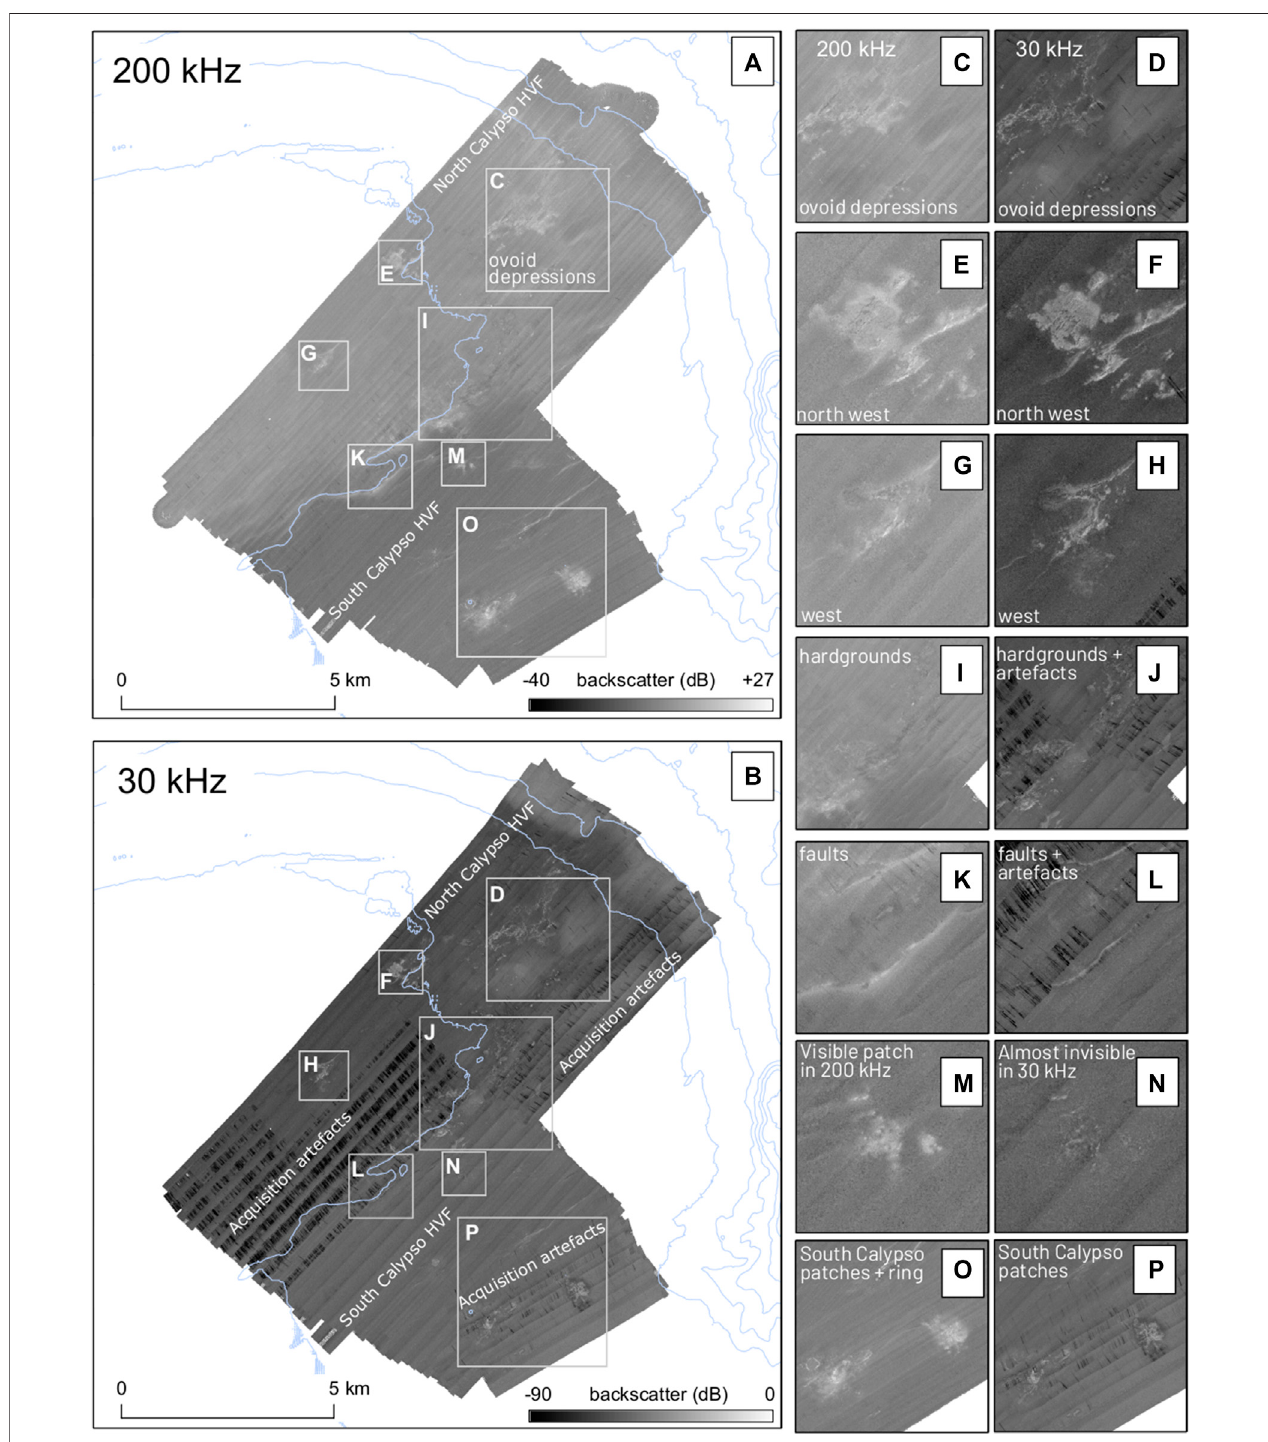
FIGURE3| OriginalCalypsoHVFEM2040(200 kHz)backscattermosaic (A) ,andCalypsoHVFEM302(30 kHz)backscattermosaic (B) , (C) , (D) , (E) , (F) , (G) , (H) , (I) , (J) , (K) , (L) , (M) , (N) , (O) , (P) insets show detailed comparisons between the two backscatter mosaics. High backscatter intensities (high re fl ectivity (cid:1) harder substrate) are lighter; low backscatter intensities (low re fl ectivity (cid:1) softer substrates) are darker. Blue lines are 50 m contours; mosaic resolution 2 m; projection NZTM. Very dark areas (black) in the 30 kHz mosaic show acquisition artefacts from aeration of the transducer due to rough sea conditions. Although original mosaic ranges shown include extreme outliers, color ramps are normalized here to ensure comparable grey tones. Mosaic distributions predominantly lie within − 30 – − 5 dB.